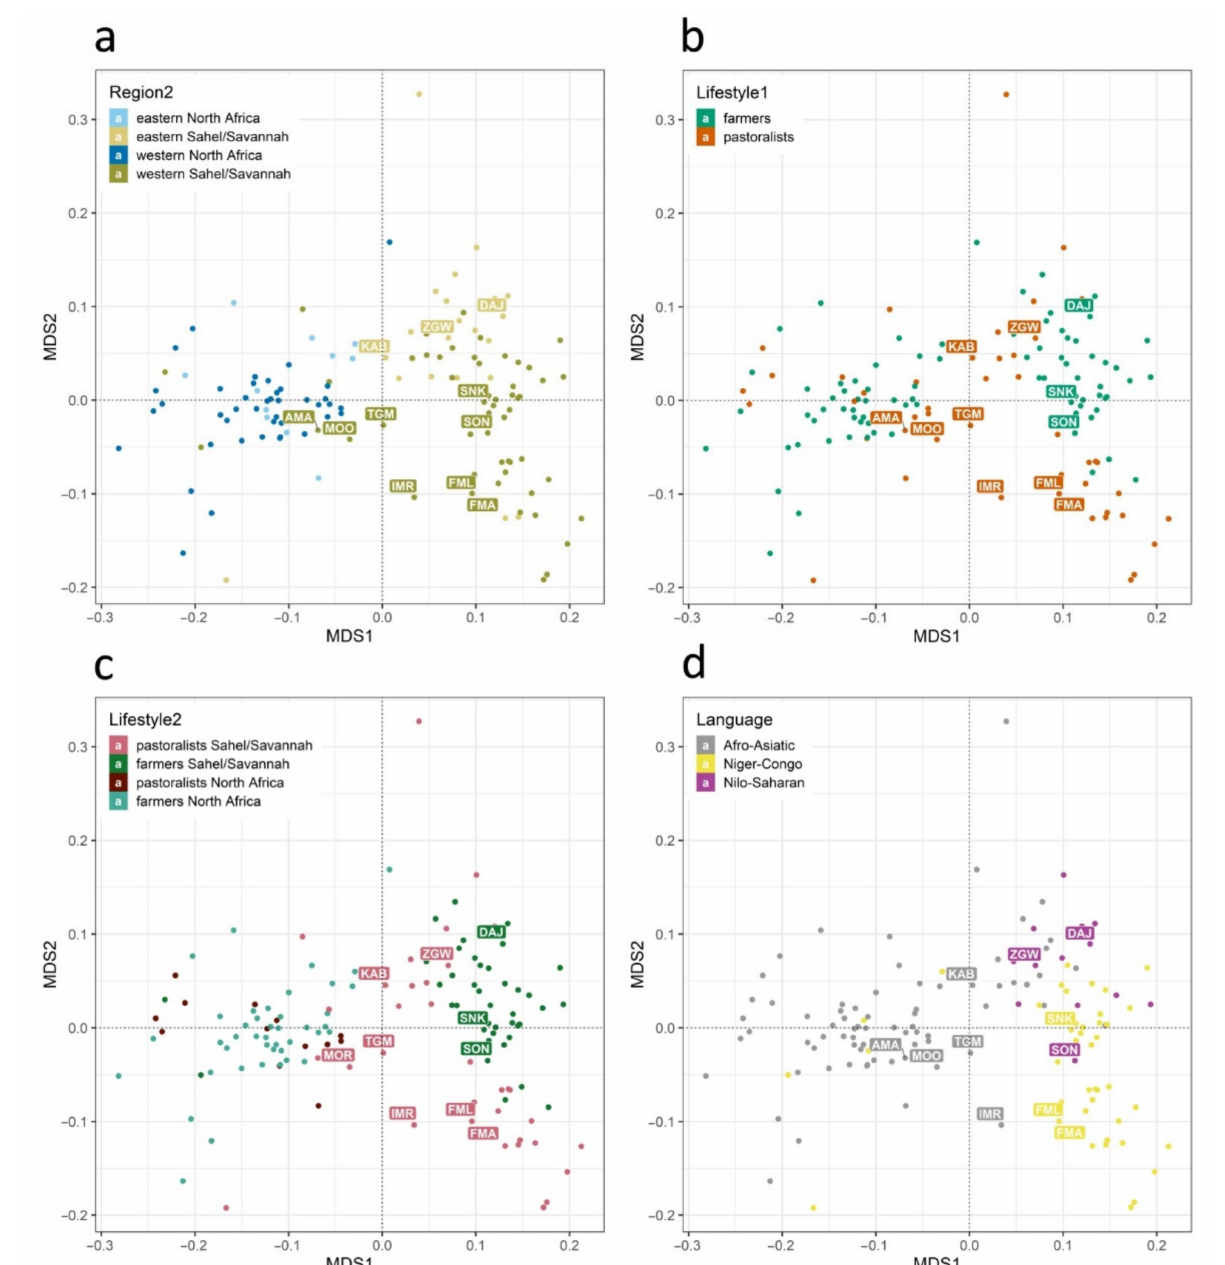
Figure 3. MDS plot (stress value 0.112) of pairwise mtDNA genetic distances between 134 populations colored according to geography as Region2 ( a ), subsistence as Lifestyle1 ( b ) and Lifestyle2 ( c ), and Language ( d ). Only newly collected populations are highlighted with